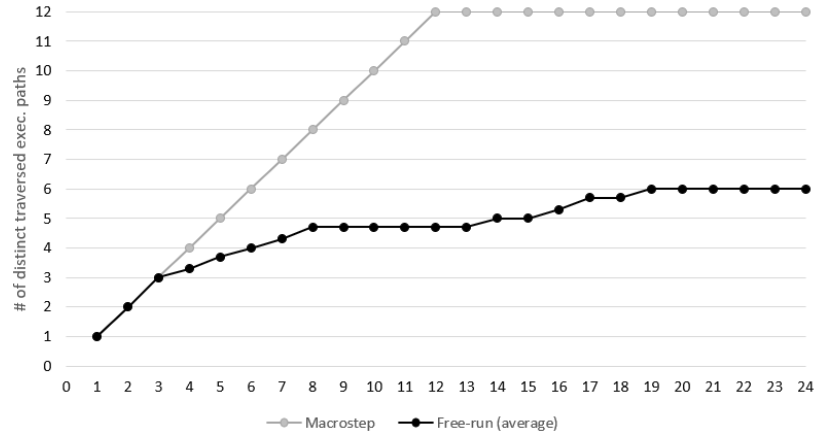
Figure 10. Overall number of covered execution paths during automatic debugging and